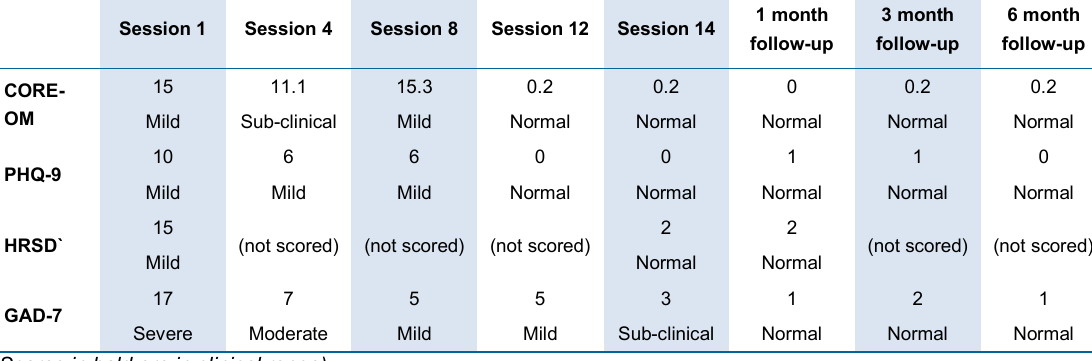
Table 1: Quantitative Outcome